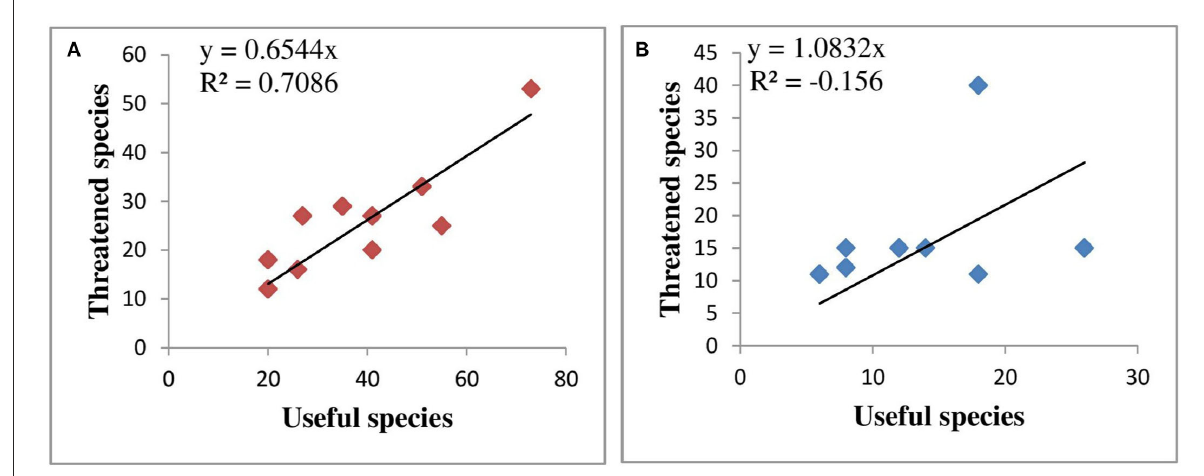
FIGURE6 Correlation between useful species and threatened species (A) forest zone (B) alpine zone.